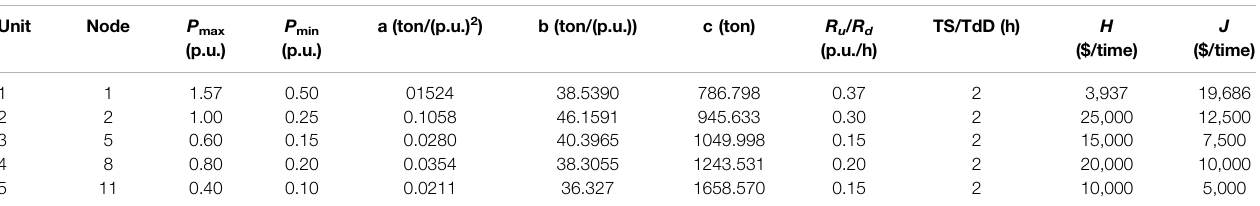
TABLE 2 | Initial data of thermal power units. Unit Node